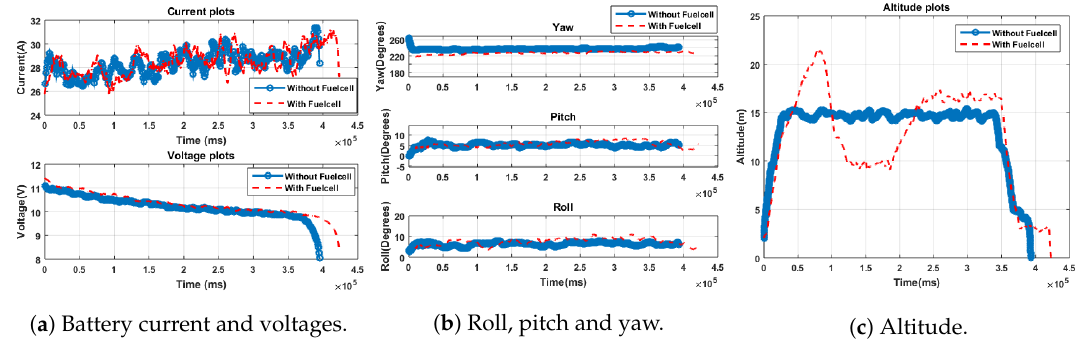
Figure 12. Flight test 1—flight parameters, with and without fuel cell. Table 4. Summaryofvarioustestsconductedwithbatteriesofvariouscapacities,fromdifferentmanufacturers.